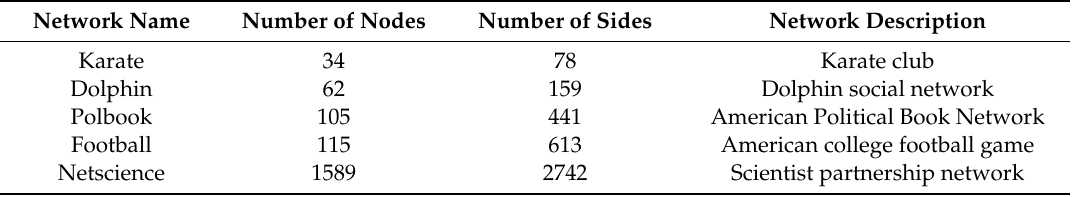
Table 1. Real network data set.